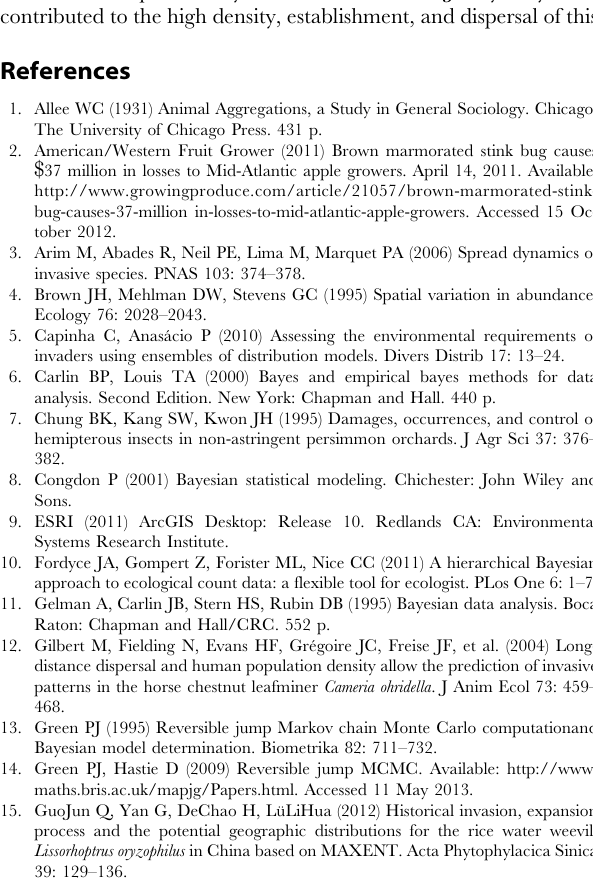
Table S1 Density of H. halys captured from black